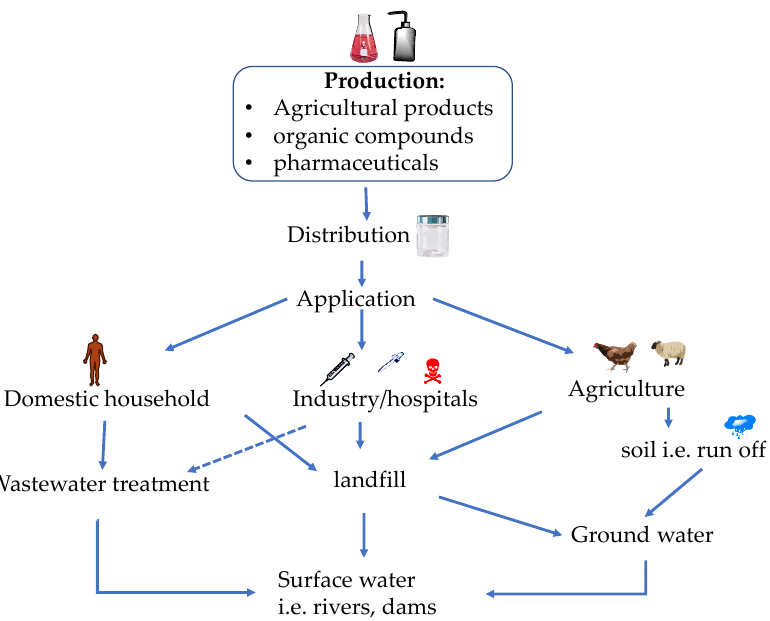
Figure 2. A path of micropollutants from production to drinking water, as adapted from Kanaujiya et. al. and Kümmerer et.al., respectively [55,56].